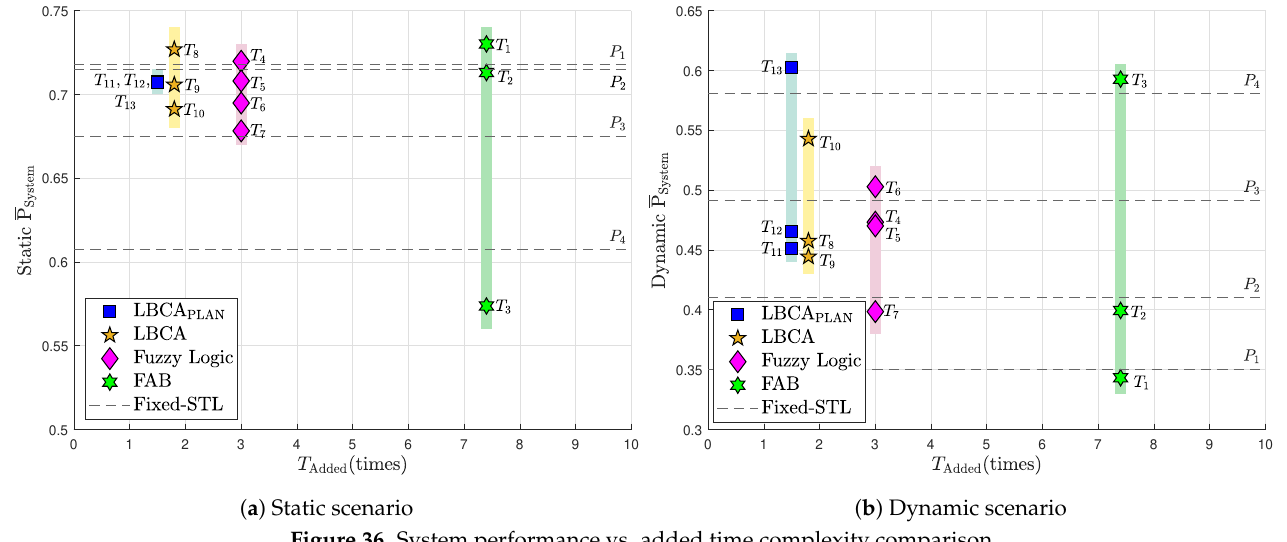
Figure 36. System performance vs. added time complexity